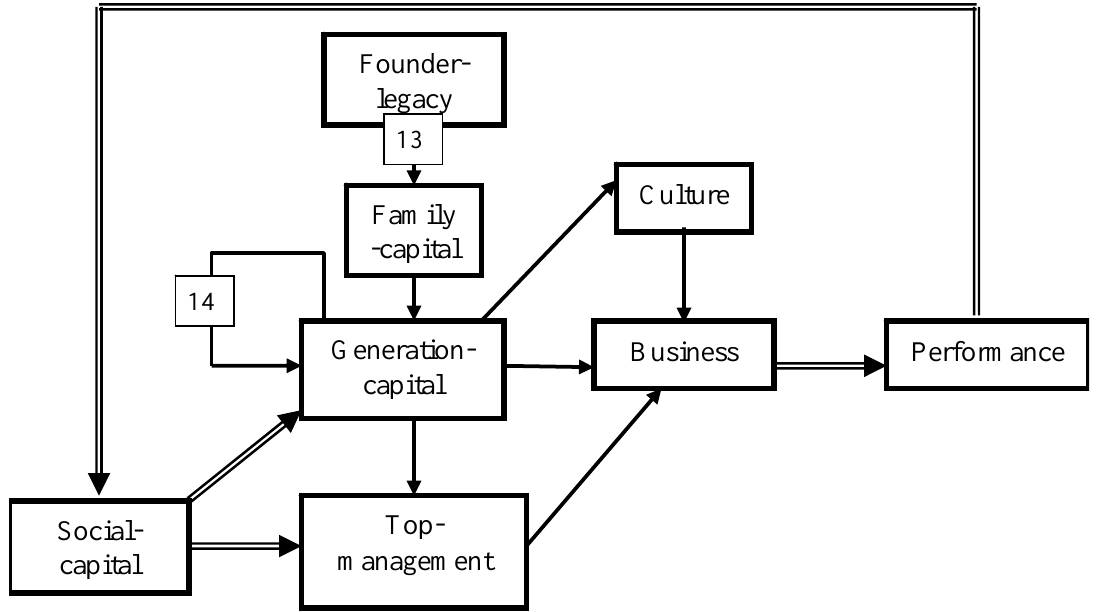
Figure 5: Creation and transmission of familiness in stage three – generational capital A conceptual familiness transmission of capital